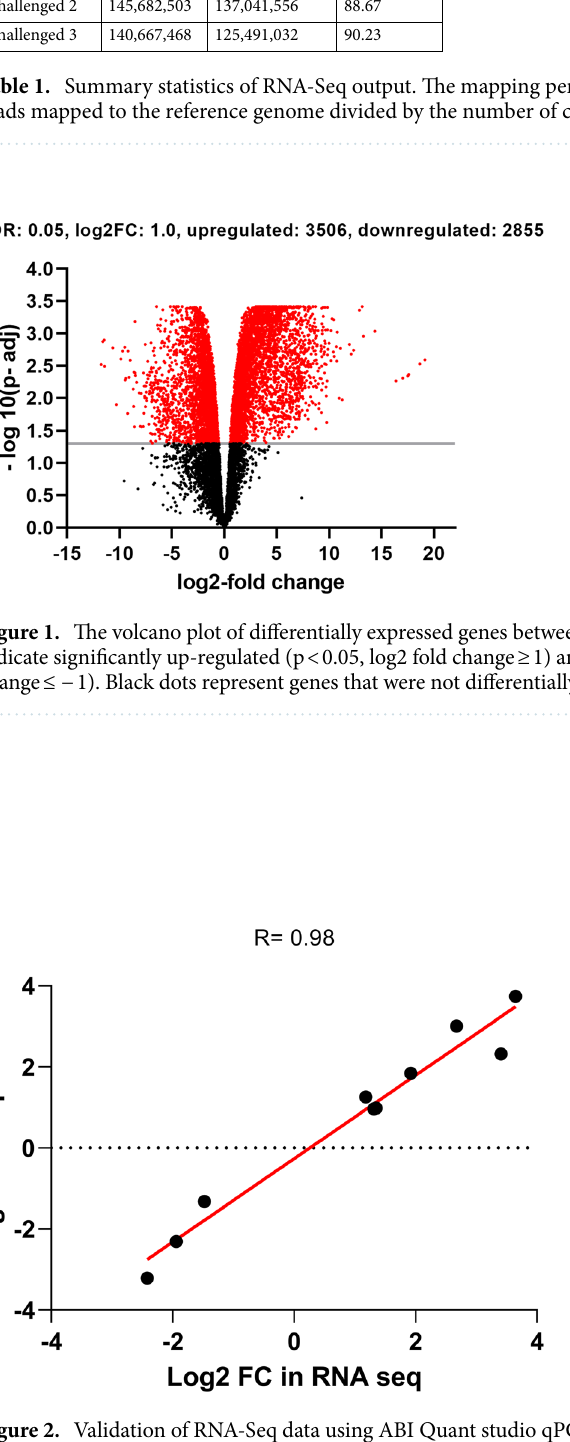
Figure 2. Validation of RNA-Seq data using ABI Quant studio qPCR system. The mean expression of ten selected genes was calculated by − ΔΔCT method and normalised by mean of Ct values of YWHAZ and TBP YWHAZ as reference genes. The values were converted into log 2 fold change (LFC). Each dot point represents one gene. Pearson correlation coefficient test used to compare the results and its value labelled as “R”. Plus (+) and minus (−) signs indicate log 2 FC values for the upregulated and downregulated genes,